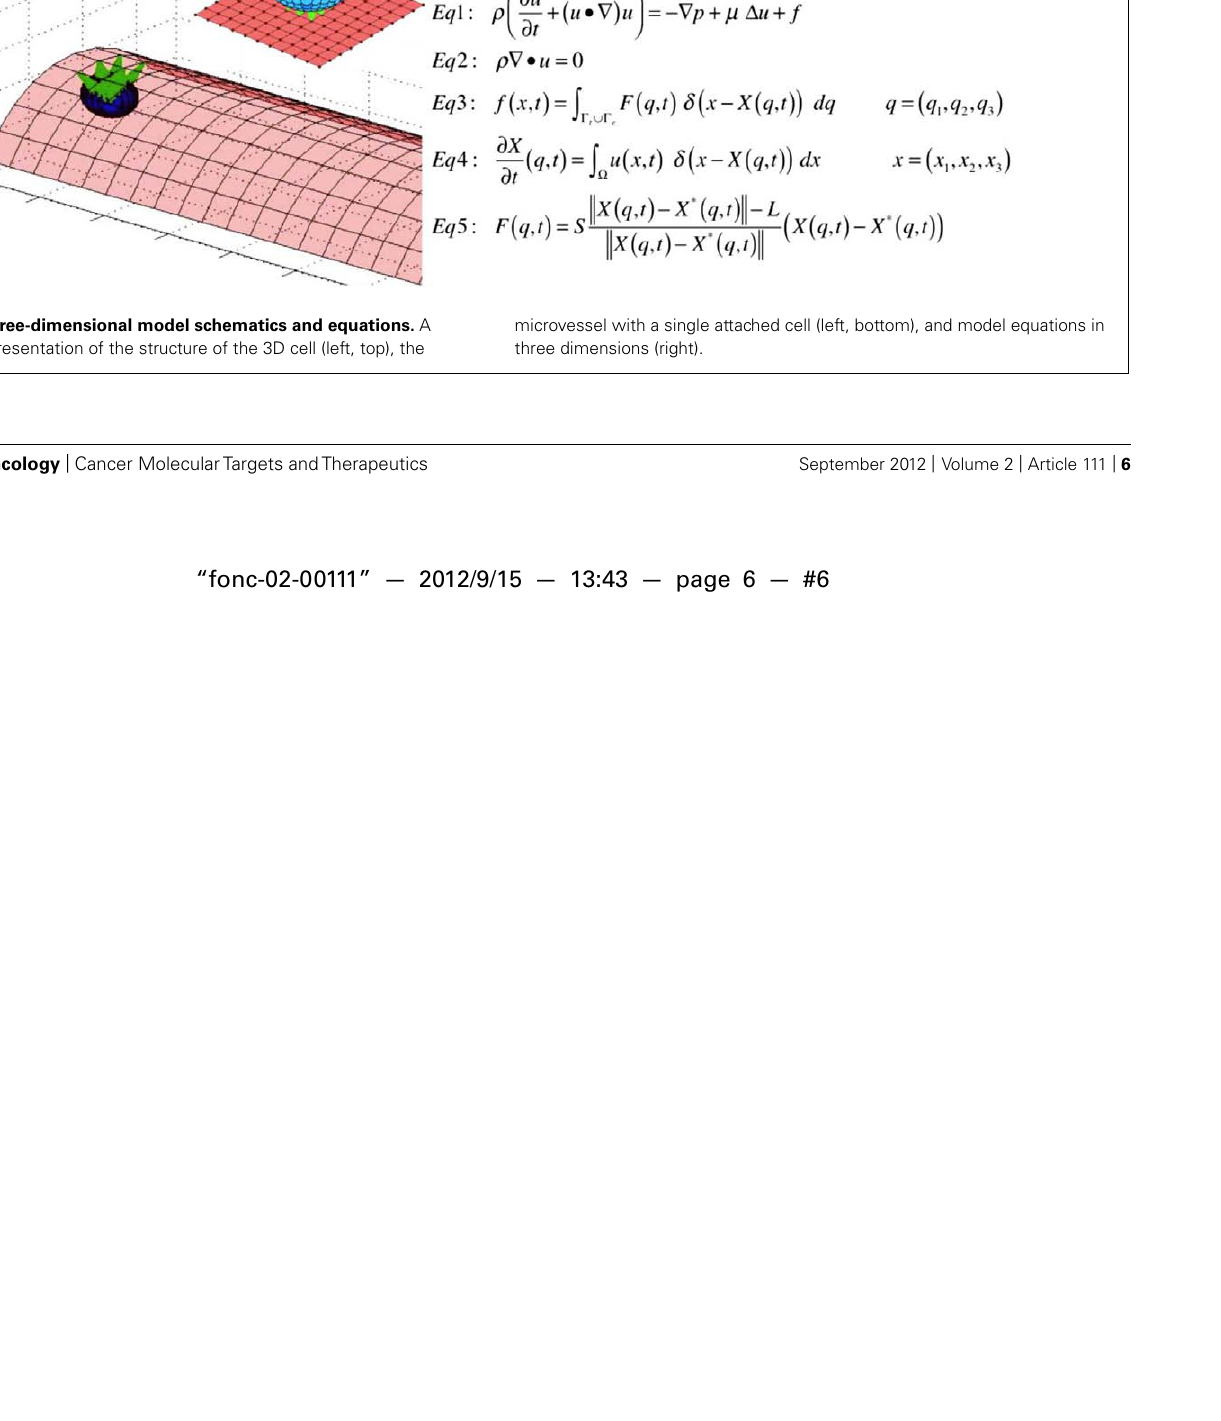
FIGURE 6 |Three-dimensional model schematics and equations. A schematic representation of the structure of the 3D cell (left, top), the